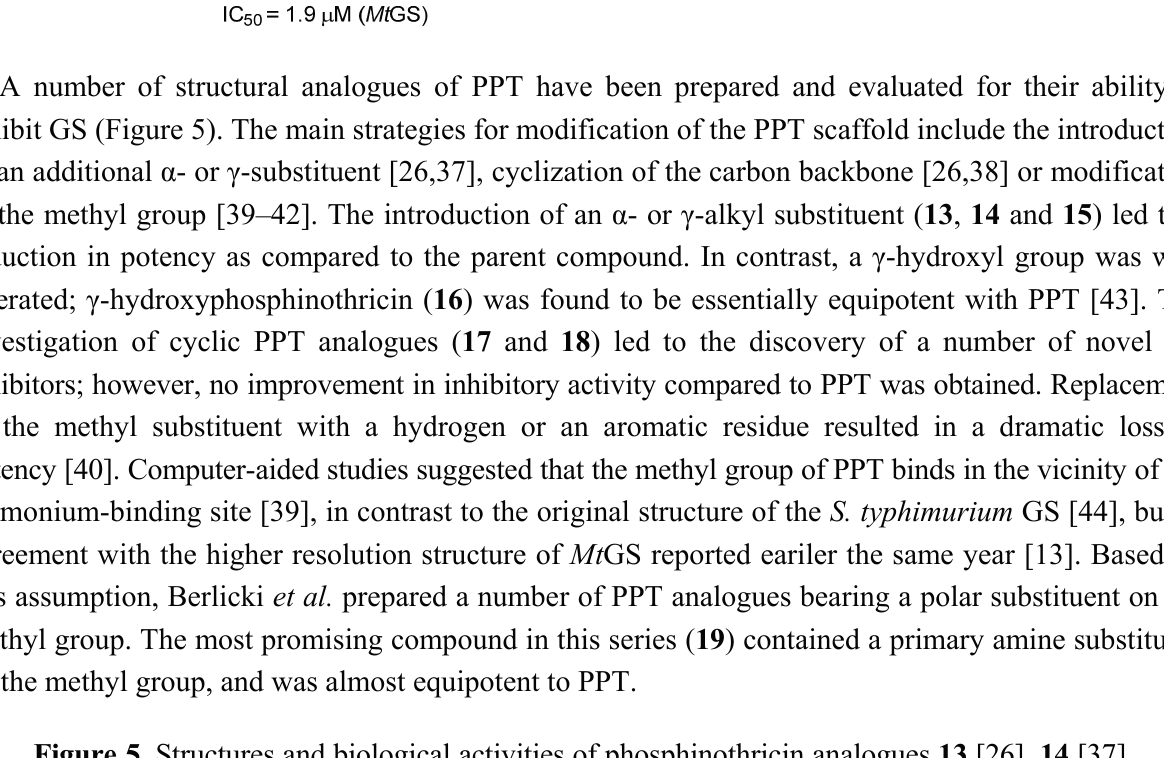
Figure 5. Structures and biological activities of phosphinothricin analogues 13 [26], 14 [37], 15 [26], 16 [43], 17 [26], 18 [38] and 19